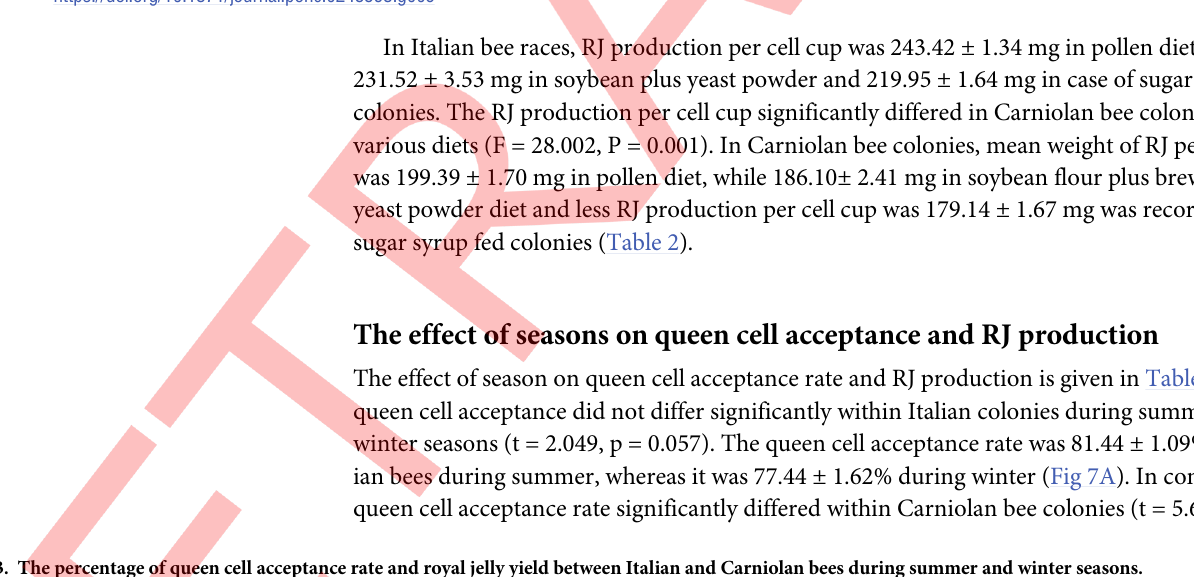
Table 3. The percentage of queen cell acceptance rate and royal jelly yield between Italian and Carniolan bees during summer and winter seasons. Season